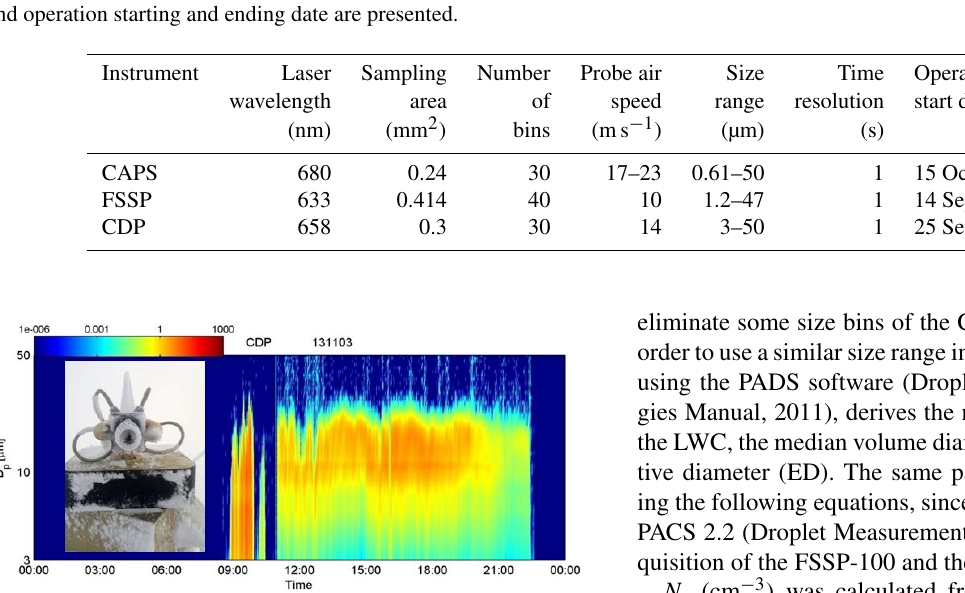
Figure 2. An example case of the CDP probe where its rotational platform and inlet are frozen. The size distribution of the CDP probe on 3 Nov 2013 is depicted. The instrument was out of order from 00:00 to about 11:30LT (all times in this paper are given as local time), and a CDP cleaning procedure was needed to start operation